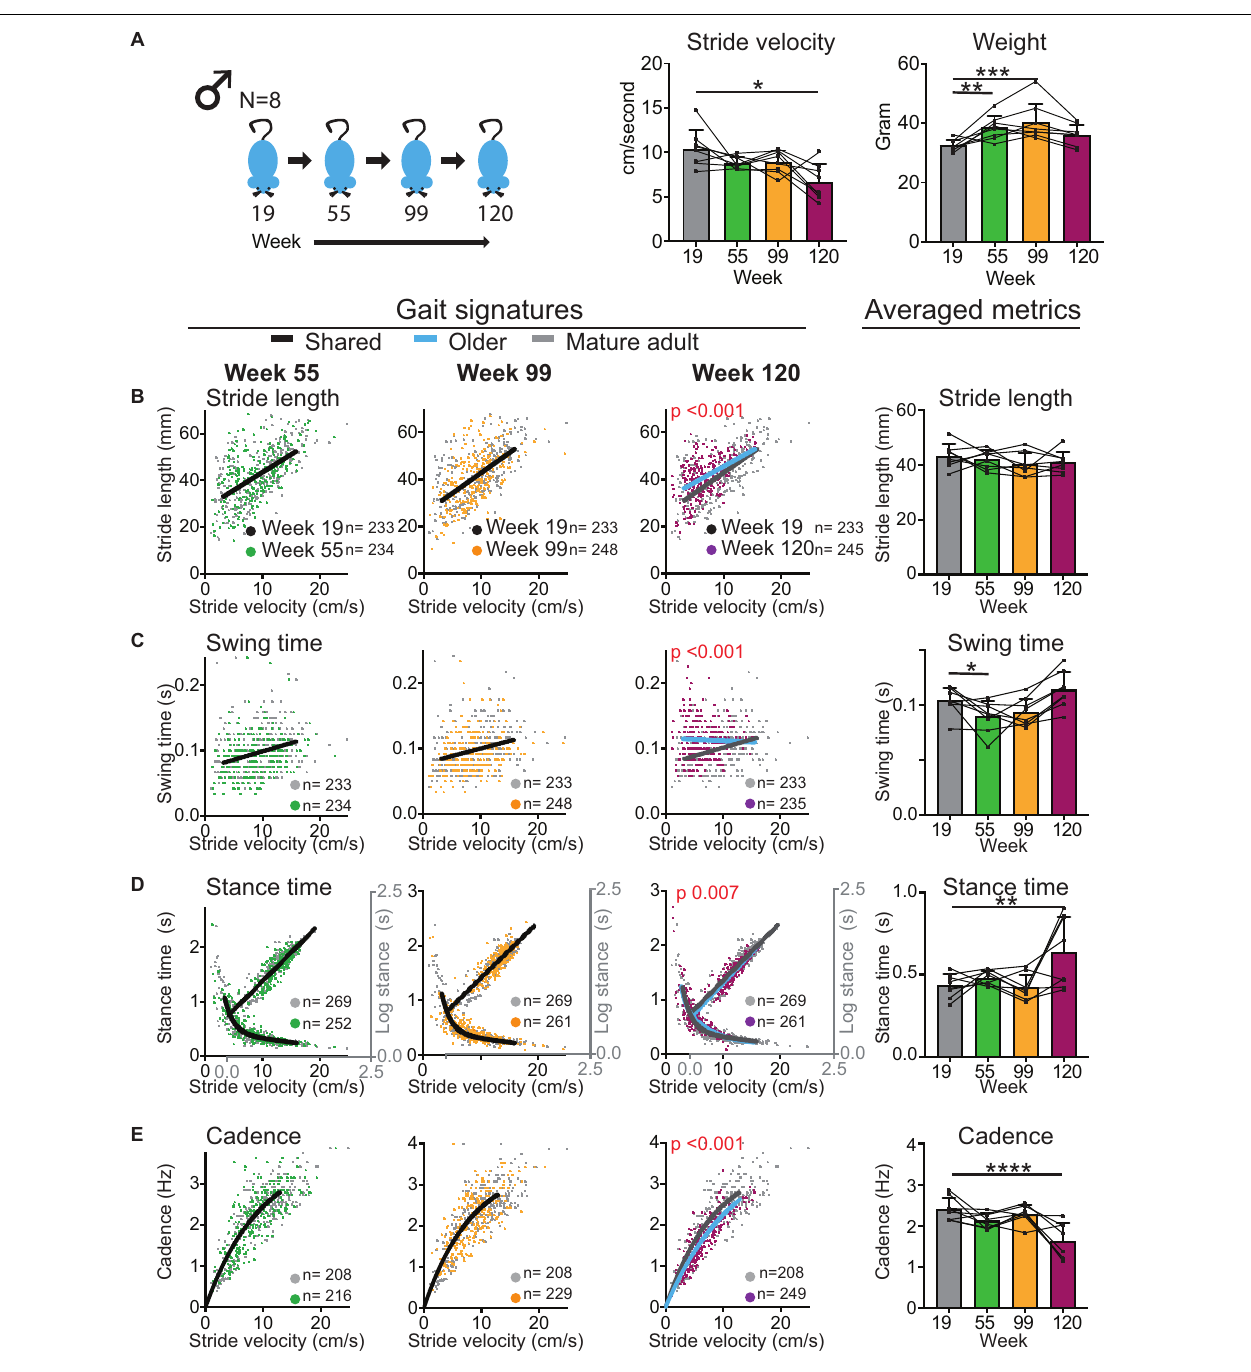
FIGURE 4 | Gait signatures in male mice shift at the geriatric time point with an accompanying decline in walking speed. (A) Bar graphs of weight and average stride velocity from continuous walking bouts on a walkway at key time points in the sub-cohort of male mice that reached the 120 week end point. Error bars indicate standard deviation. RM-one-way ANOVA followed by Dunnett’s multiple comparison test with correction for multiple comparisons; family alpha 0.05. (B–E) Stride by stride gait metrics stride length (B) , swing time (C) , stance time (D) and cadence (E) plotted as a function of stride by stride velocity. Gray dots represent data from week 19 (mature adult) whereas green, orange and purple represent data from weeks 55, 99, and 120, respectively. Single curves or lines indicate that the dataset from week 19 and older time points fit the same curve, whereas separate lines indicate that datasets cannot be fitted in the same model and are significantly different (Sum of square F -test; alpha 0.001). Note the shift in curves or gait signatures (blue lines) in the geriatric age group (week 120). Bar graphs to the right show averaged metrics to illustrate variation between animals and time points. Error bars indicate standard deviation. Curves were fitted for the velocity range that represents walking gait. N = number of mice; n = number of strides included in the analyses. RM-one-way ANOVA followed by Dunnett’s multiple comparison test with correction for multiple comparisons; family alpha 0.05. *, **, ***, and **** represent p values of < 0.05, < 0.01, < 0.001, and < 0.0001, respectively. Statistical analyses are summarized in Supplementary Table 3